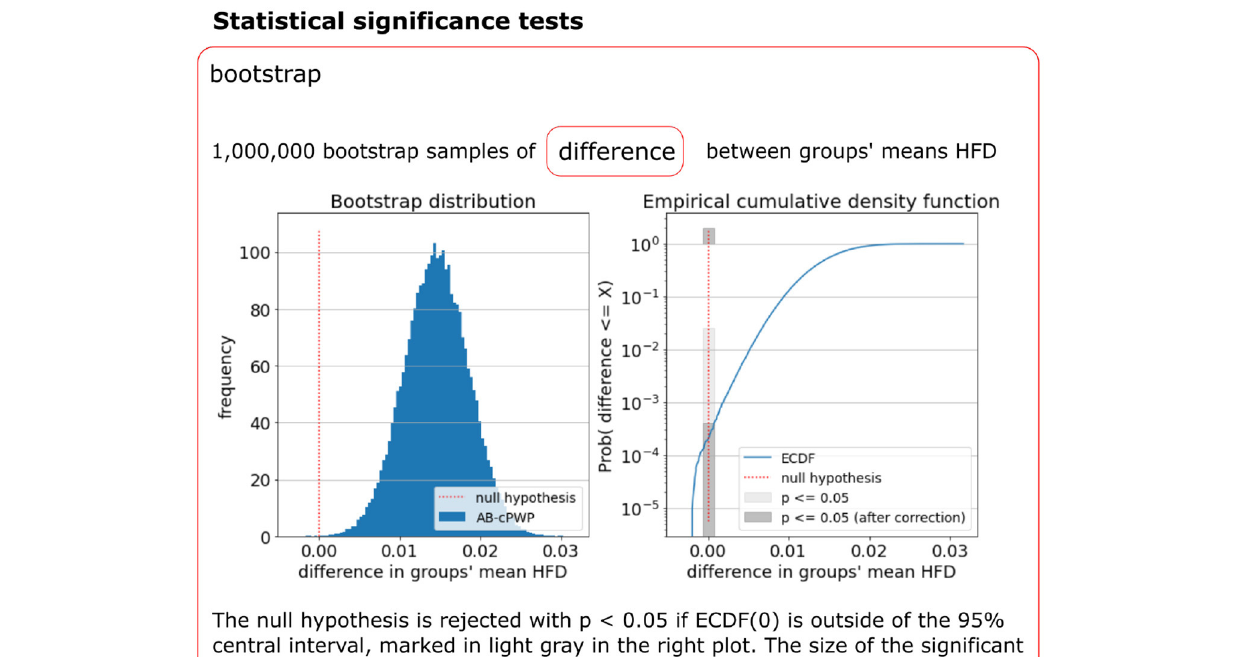
locations C1, C3, Cp1, Cp3. There is no systematic difference in mean HFD across time windows which start at different times with respect to the cue-based movements. The largest